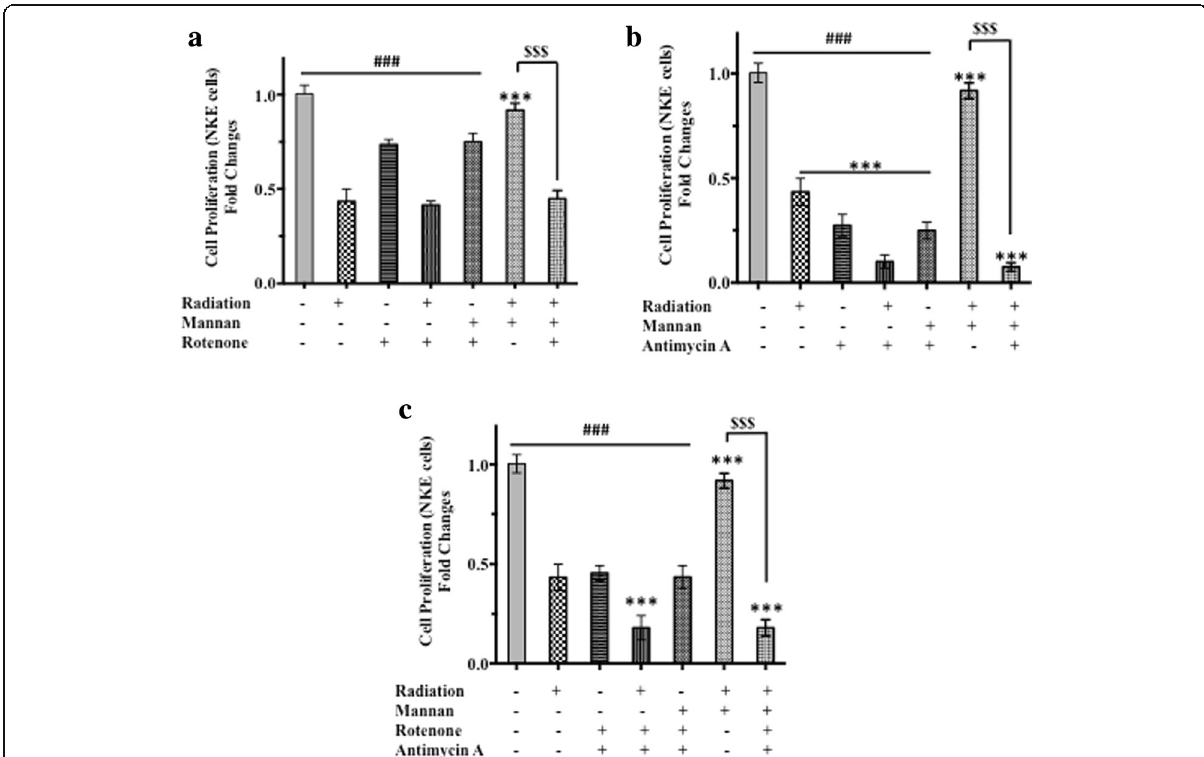
Fig. 5 Studies on requirement of functional ETC for radiation protection offered by mannan. The requirement of functionality ETC in radiation protection was assessed using inhibitors of complex I and Complex III. Briefly cells were treated with ( a ) Rotenone, inhibitor of complex I, ( b ) Antimycin A, inhibitor of complex III, ( c ) Both Rotenone and antimycin A, 30 min prior to mannan treatment and/or irradiation followed by SRB uptake after 96 h as described under materials and methods. Results are expressed as fold changes in cell proliferation ± SD of three independent experiments. Differences were designated significant at values * p < 0.05, ** p < 0.001 and *** p < 0.0001 and were labeled as # compared with the sham irradiated control group , * compared with the radiation group, and $ compared with radiation + mannan